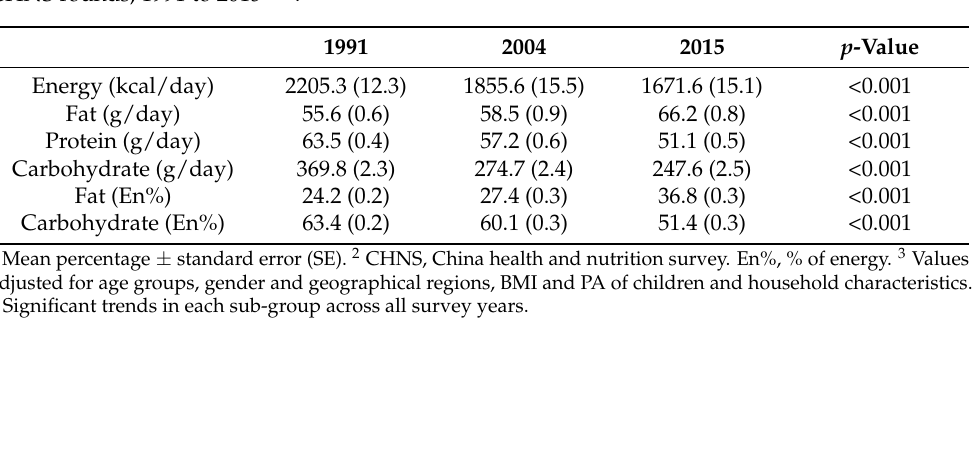
Table 2. Trends of the daily energy and macronutrient composition of children aged 6 to 17 years by CHNS rounds, 1991 to 2015 1–4